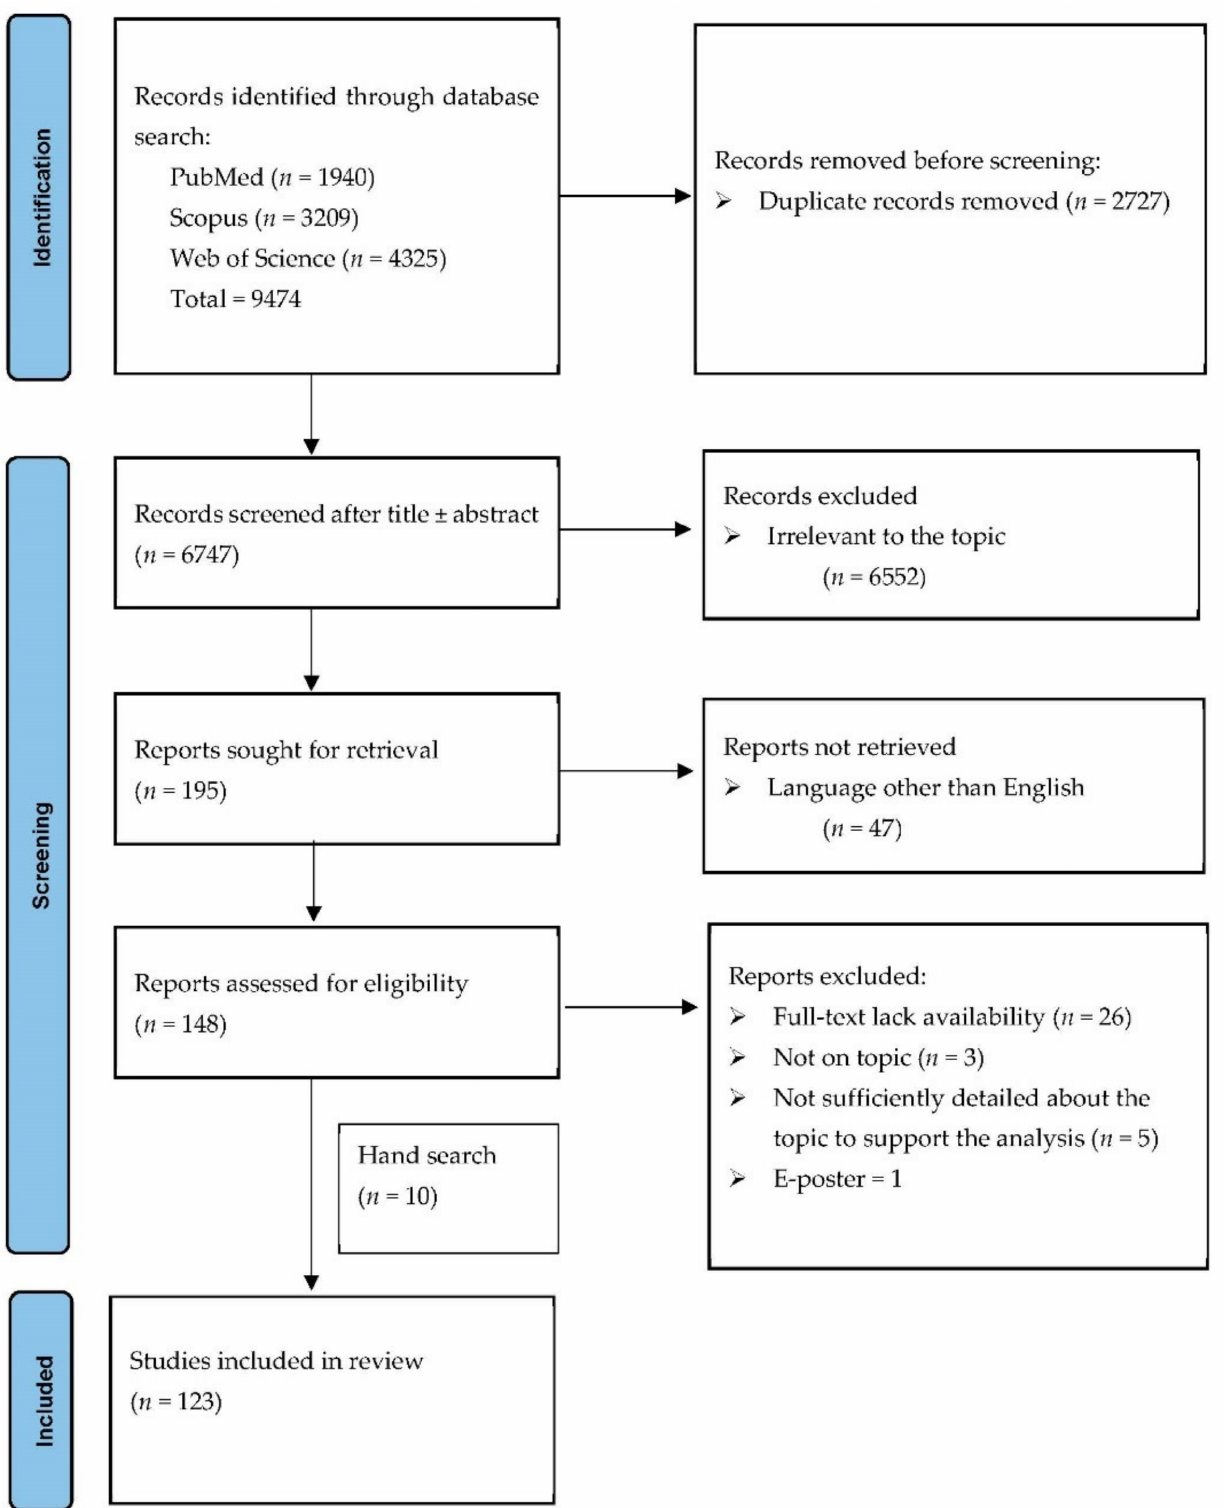
Figure 1. PRISMA flow diagram for the selection process of the